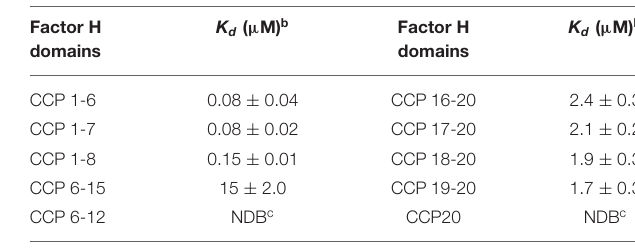
TABLE 1 | Binding a of C3b by different regions of Factor H.